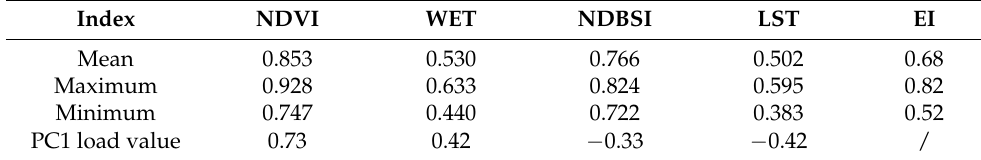
Table 7. Statistics of ecological index (EI) and